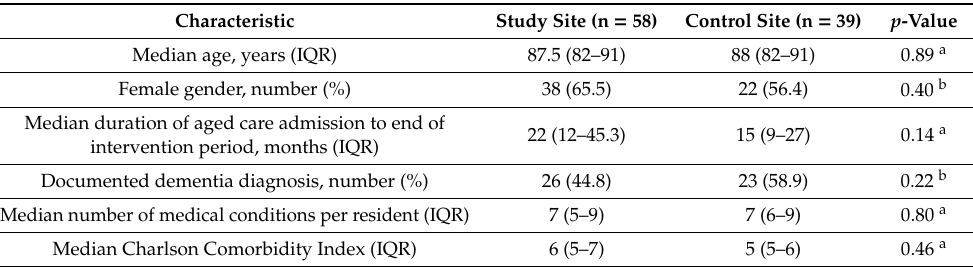
Table 1. Participant